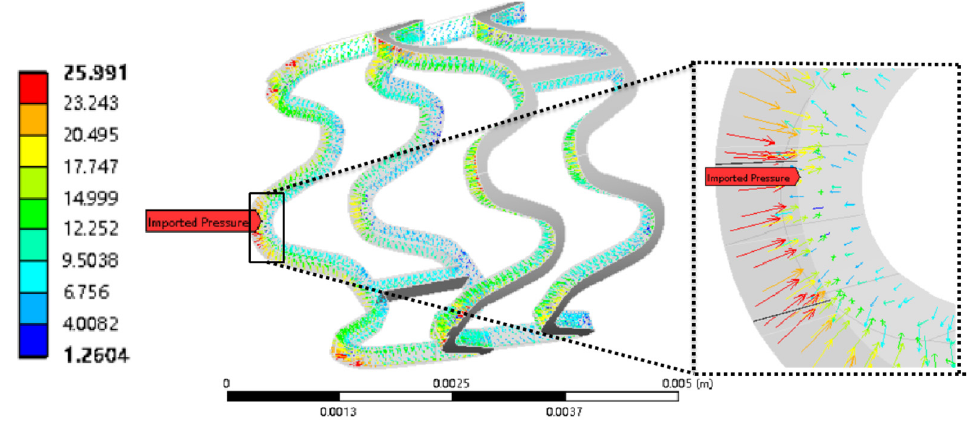
Figure 17. Pressure distribution of blood acting on the coronary artery stent at the maximum moment.